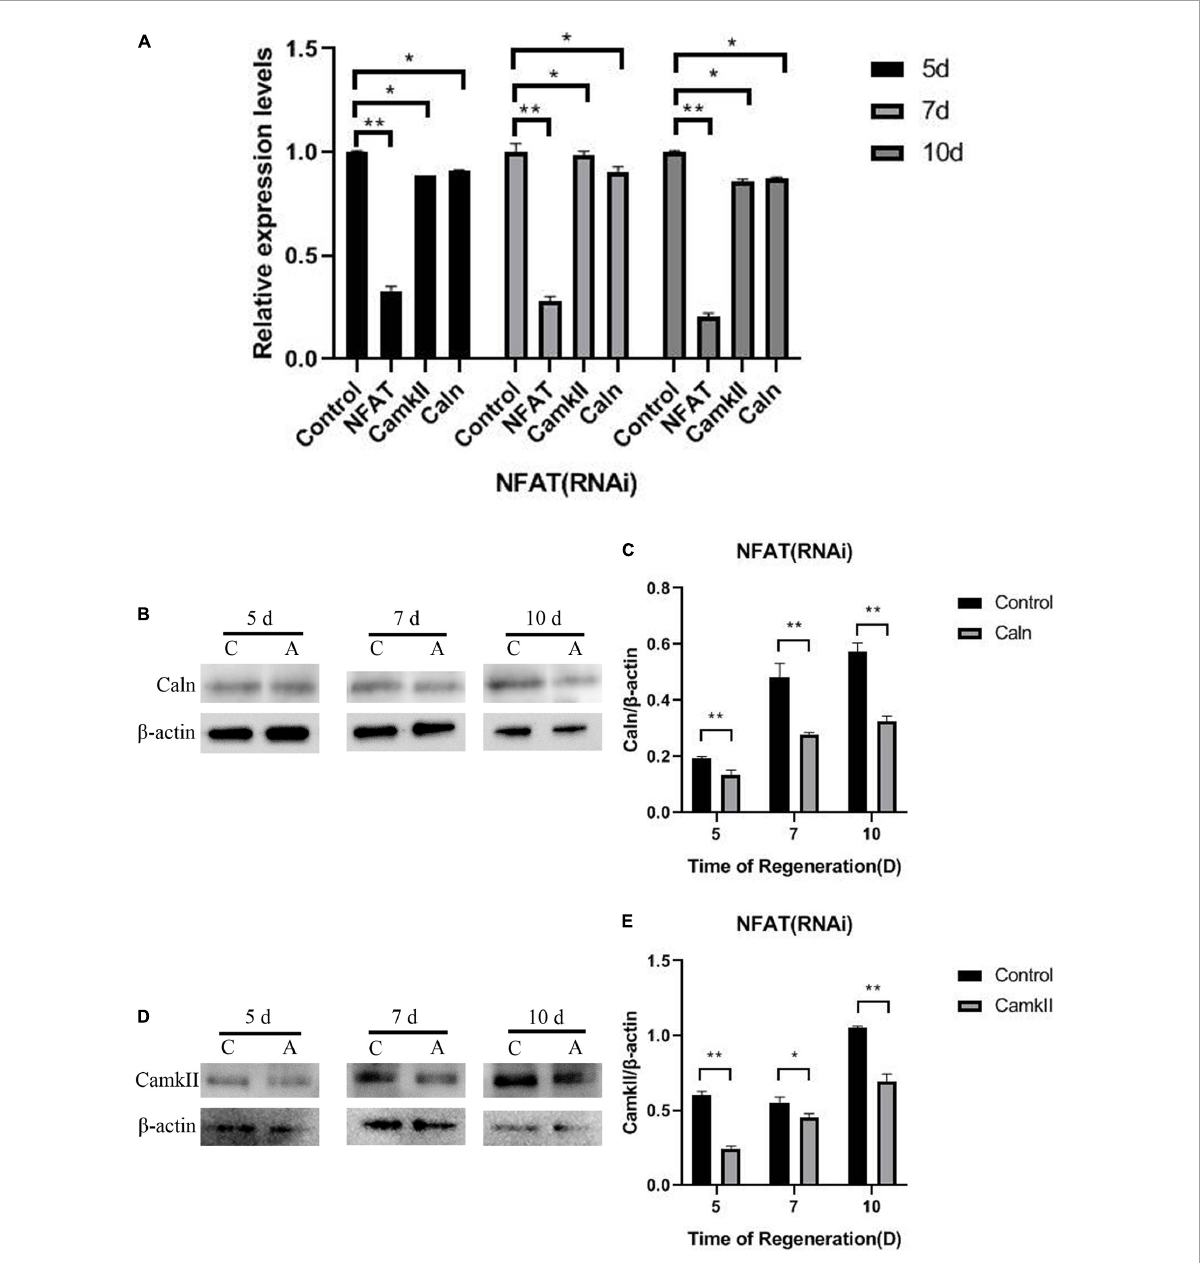
FIGURE4 DjNFAT regulates DjCaln and DjCamkII by feedback positive regulation during planarian head regeneration. (A) DjCaln and DjCamkII mRNA level in DjNFAT (RNAi) planarians at 5, 7, and 10 days during planarian head regeneration, n = 4. (B , C) Relative DjCaln protein level in DjNFAT (RNAi) planarians at 5, 7, and 10 days during planarian head regeneration, n = 5. (D,E) Relative DjCamkII protein level in DjNFAT (RNAi) planarians at 5, 7, and 10 days during planarian head regeneration, n = 5, * P < 0.05, ** P < 0.01. C, control; A, DjNFAT